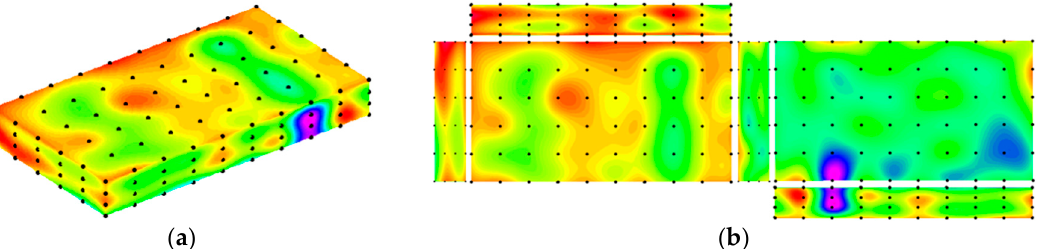
Figure 5. Anatomy of a grain temperature sensor network; ( a ) full view of a grain temperature field, ( b ) grain temperature sensor network based on a six-view plot. Table 1. Physical properties of stored grains.